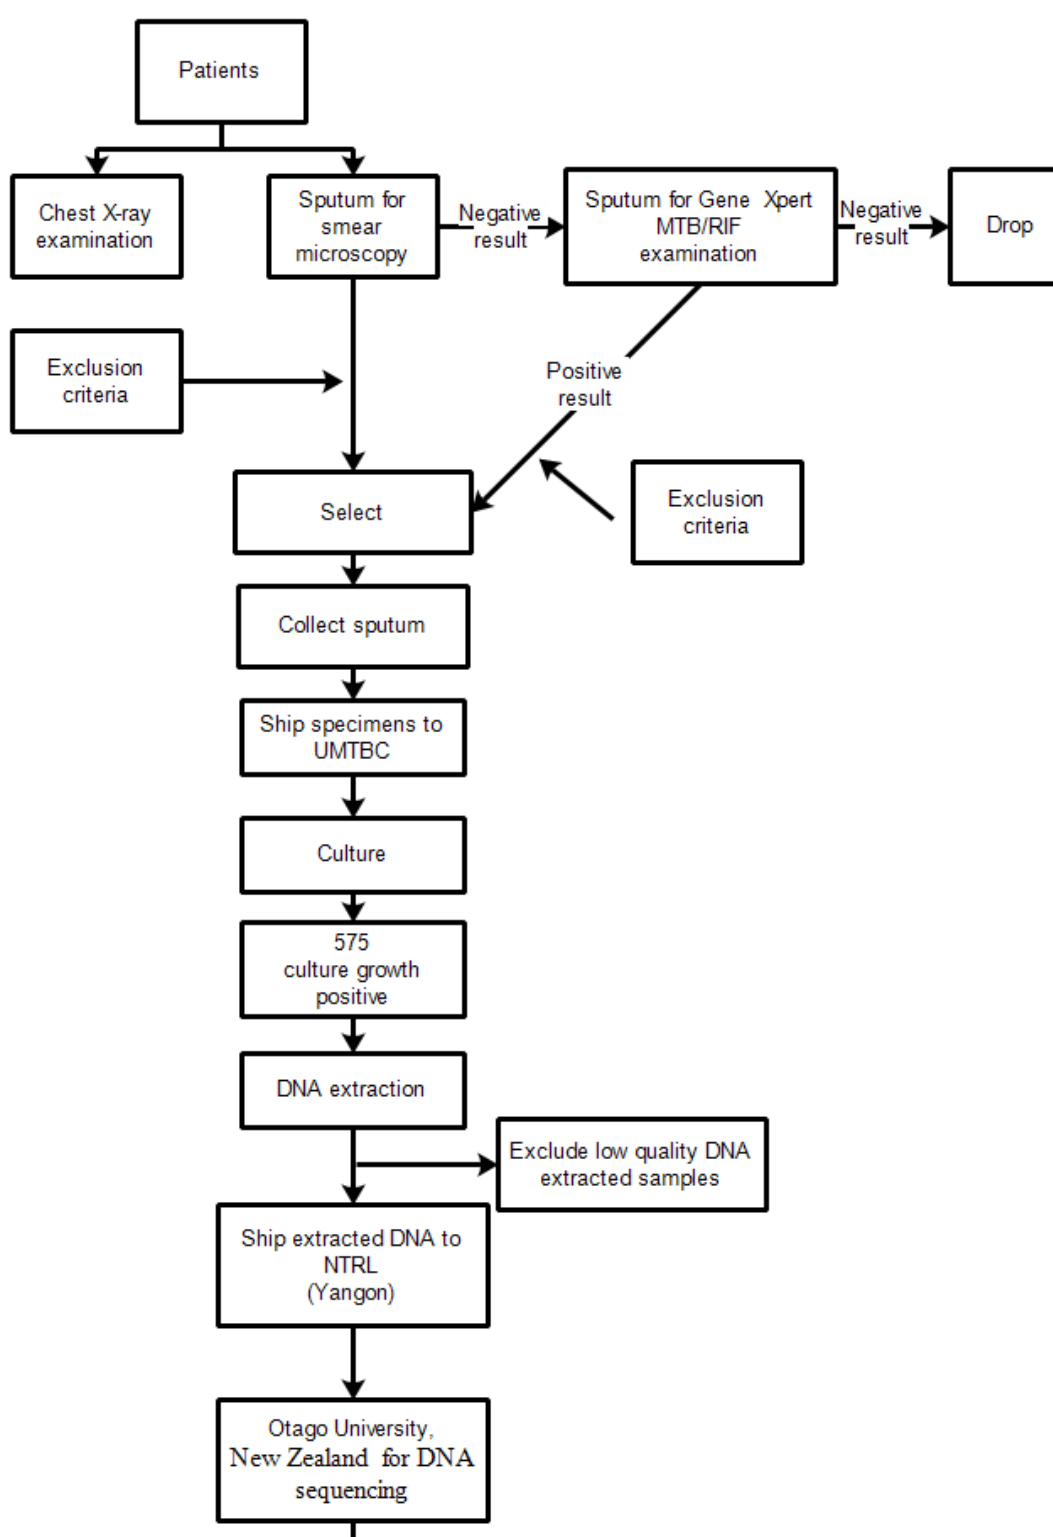
Figure 2. Laboratory workflow at the culture facility in Upper Myanmar and Otago University, New Zealand.